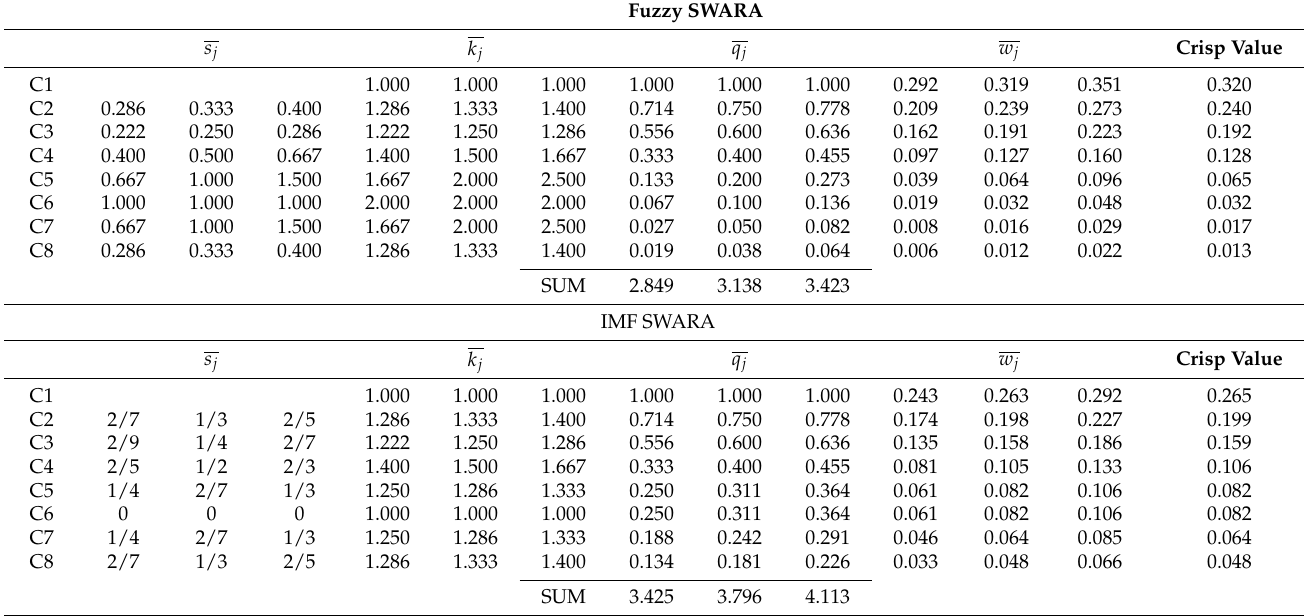
Table 5. Comparative analysis of fuzzy SWARA and improved fuzzy SWARA (IMF SWARA) in another example. Fuzzy